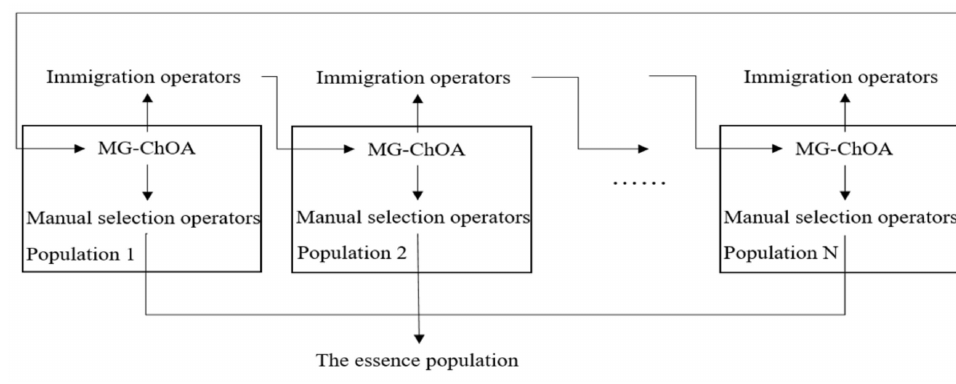
Figure 4. The description of the multiple-population strategy.